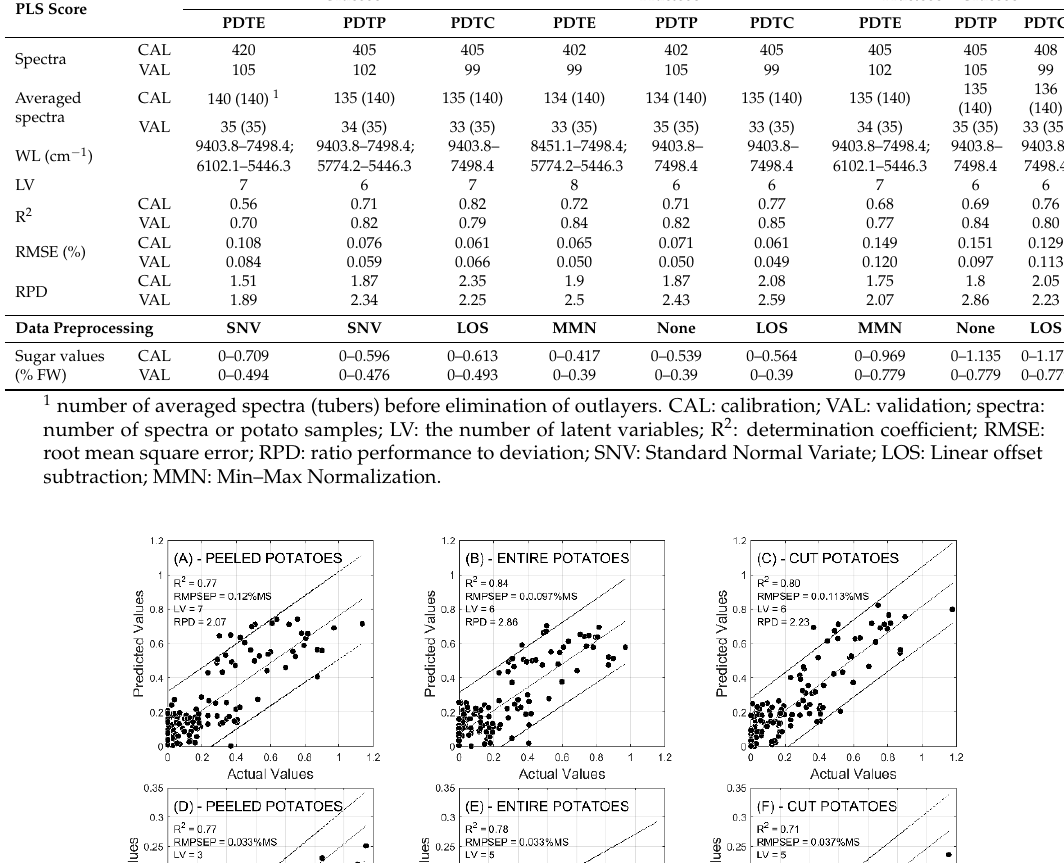
Table 4. PLS values of sugar content prediction of the potato variety Markies.